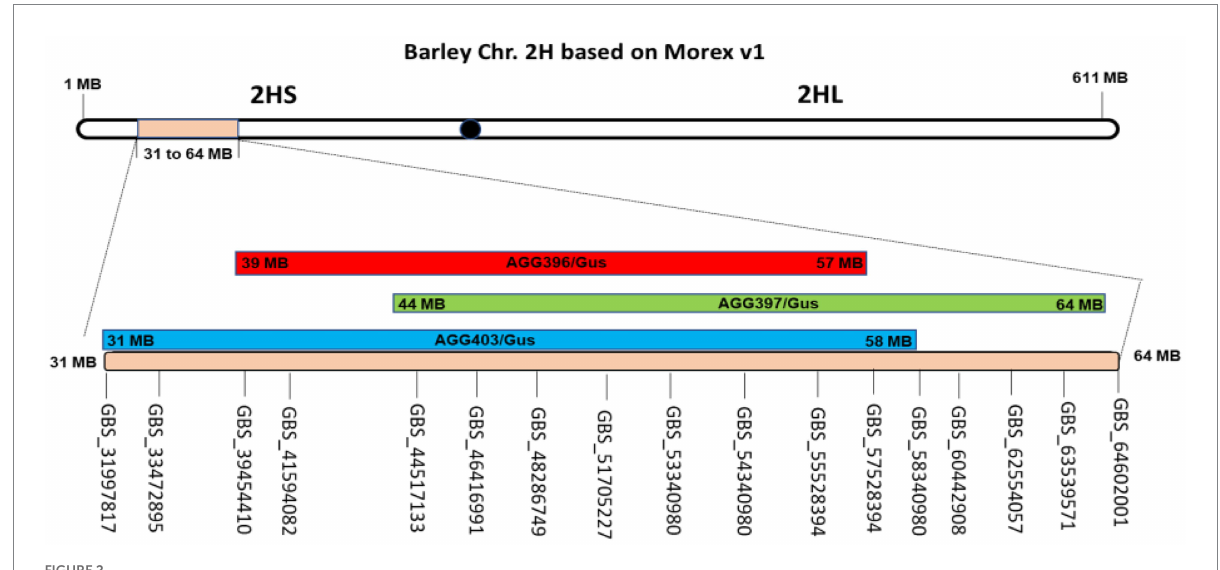
FIGURE 2 Genomic regions for AGG-396 (red), 397 (green), and 403/Gus (blue) F 3 populations identified on the short arm of chromosome 2H through tGBS. For AGG-396/Gus, AGG-397/Gus and AGG-403/Gus, the intervals linked to resistance were found from 39 to 57, 44 to 64, and 31 to 58 Mb on 2HS, respectively.